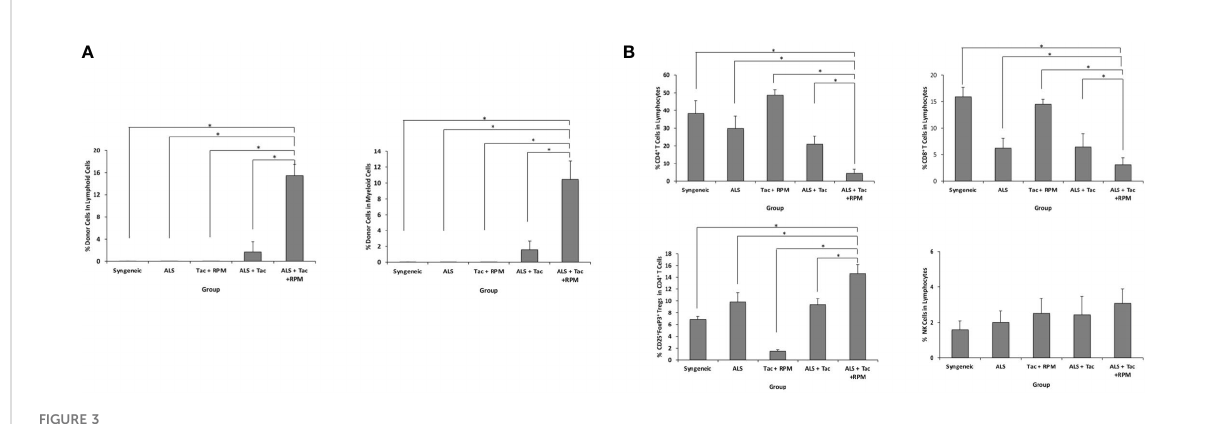
FIGURE 3 VBM transplant recipient with antilymphocyte serum combined with tacrolimus and rapamycin can induce peripheral multilineage chimerism. (A) Chimerism of recipients among different groups on postoperative day 30. (B) Peripheral blood analysis of recipients among different groups on POD 30. The asterisk denotes statistical signi fi cance ( p <